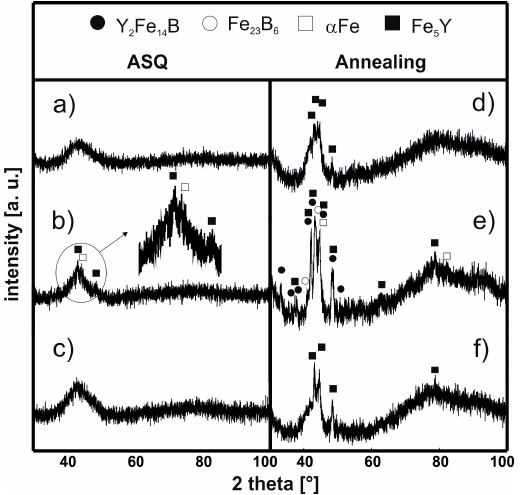
Figure 3. X-ray di ff raction patterns for the alloys in the as-cast state ( a – c ) and following the thermal treatment at 940 K for 10 min ( d – f ) produced using the injection-casting method: Fe 61 Co 10 W 1 Y 8 B 20 , ( a , d ), Fe 62 Co 9 W 1 Y 8 B 20 , ( b , e ) Fe 63 Co 8 W 1 Y 8 B 20 ( c,f